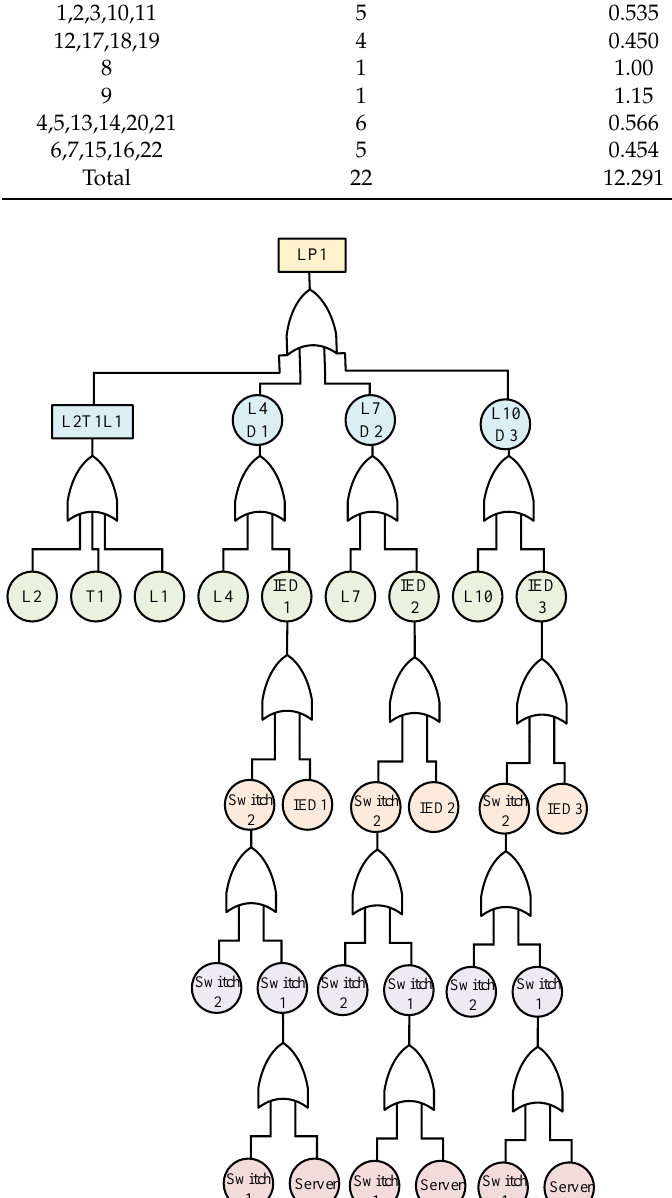
Figure A1. Fault tree for LP1.